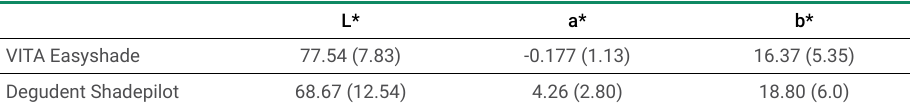
Table 1. Mean CIE L*a*b* color coordinates (Standard Deviations) Obtained in 31 participants measured with the VITA EasyShade and Degudent Shadepilot L* a*